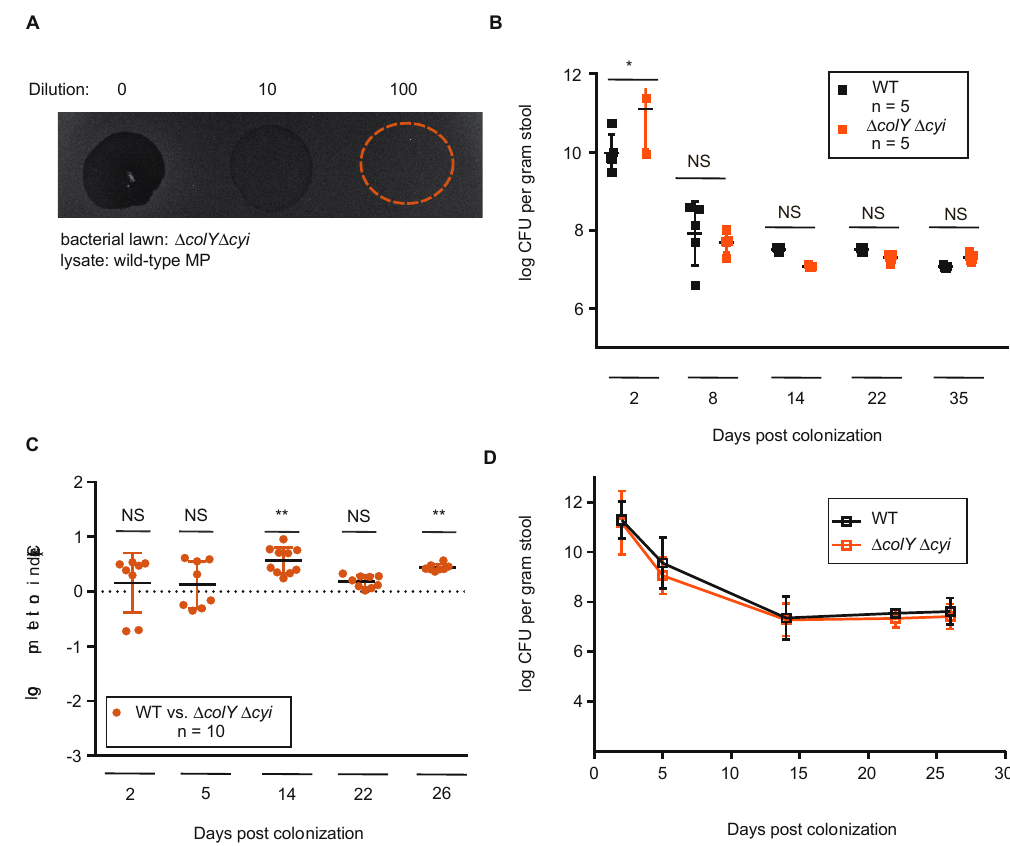
Figure 4. Characterization and colonization of the adult mouse gut by a colicin-sensitive strain. ( A ) Inhibition halo of wild-type strain exposed to 50 J/m 2 and extracted lysate spot plated on a lawn of ∆ colY ∆ cyi strain. Dilutions of cell lysates were made and indicated above. Circles indicate location of spotted lysate. ( B ) Groups of 6- to 8-week-old C57BL/6 mice were inoculated with the colicin wild-type strain or the ∆ colY ∆ cyi strain. Significant p values are noted (NS, not significant. * p > 0.05) and were calculated using a two-tailed unpaired Student’s t test. (C,D) Groups of 6- to 8-week-old C57BL/6 mice were co-inoculated. ( C ) Log competitive index (CI) was calculated by taking the ratio of the output colonies normalized to the input ratio. Each circle represents one specific animal. Significant p values are noted (NS, not significant, ** p > 0.005) and were calculated using a one sample t -test. ( D ) CFU counts per gram of feces for the competition experiment. Each square represents the mean and standard deviation from all individual mice. Limit of detection was 10 3 . If colonies were too numerous to count on a plate, the corresponding animal was excluded from the data for that day.